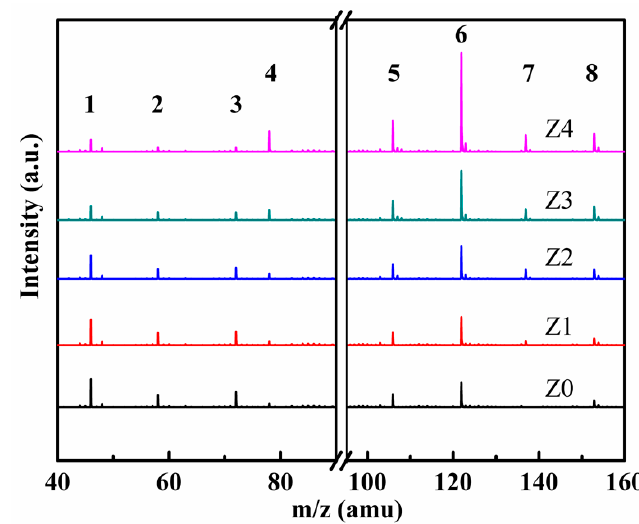
Figure 8. Time of flight mass spectrometry (TOF-MS) spectrum of organic byproducts in the gas phase over a series of HZSM catalysts in a plasma catalysis system: 1. formic acid, 2. oxalaldehyde, 3. methylglyoxal, 4. benzene, 5. benzaldehyde, 6. benzoic acid, 7. nitrotoluene, 8. nitrobenzyl alcohol.